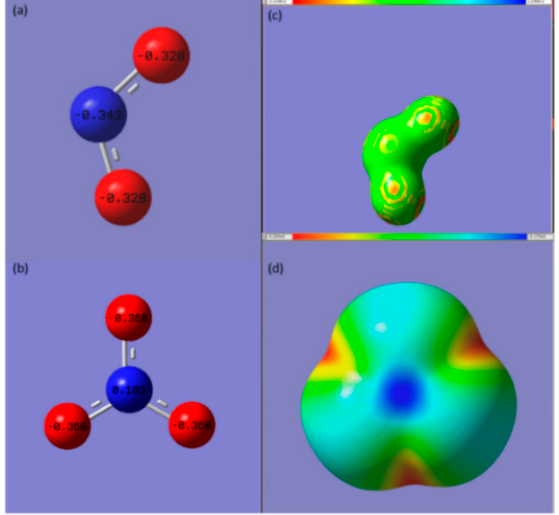
Figure 10. The optimized molecular structure with Mulliken charges for ( a ) NO 2 − , and ( b ) NO 3 − ; and the electron density mapping for ( c ) NO 2 − , and ( d ) NO 3 − .